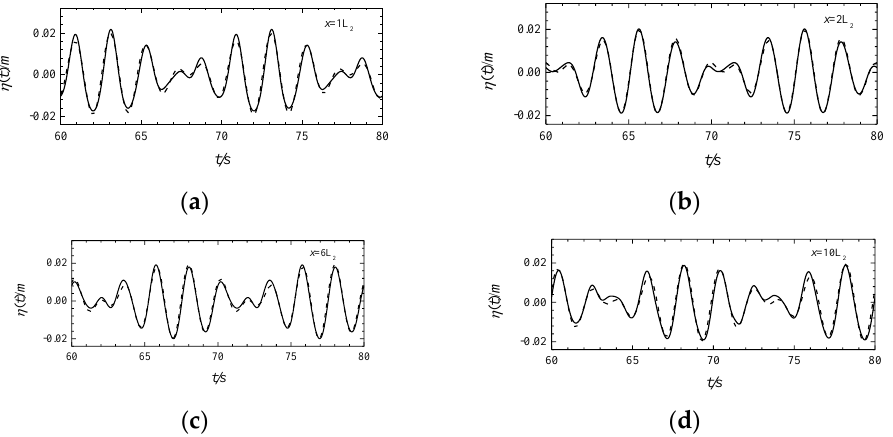
Figure 3. Comparison of the wavefront at X = 1L 2 (a), X = 2L 2 (b), X = 6L 2 (c), X = 10L 2 (d) of the MIKE 21 BW model (solid line) and the theoretical solution (dashed line) (operating condition C1).